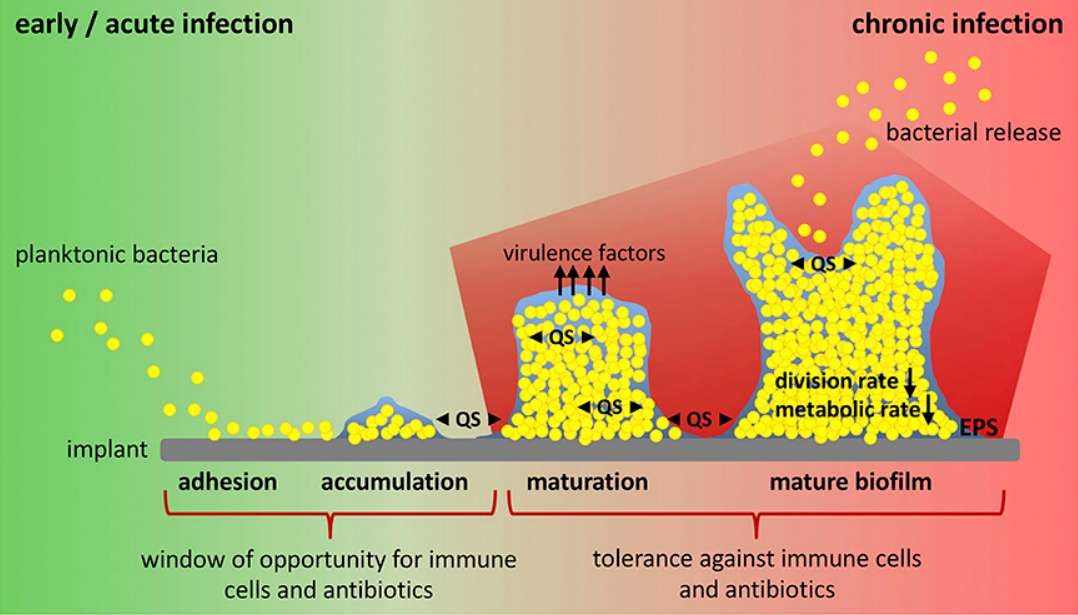
Figure 2. Scheme showing biofilm formation and window of opportunity for effective clearance of bacteria. Biofilm formation leads to an increased tolerance against the immune system, antibiotics, and possible chronicity of the infection. QS and EPS indicate quorum sensing intercellular signalling molecules and extracellular polymer substances, respectively. Reproduced with permission from [6].